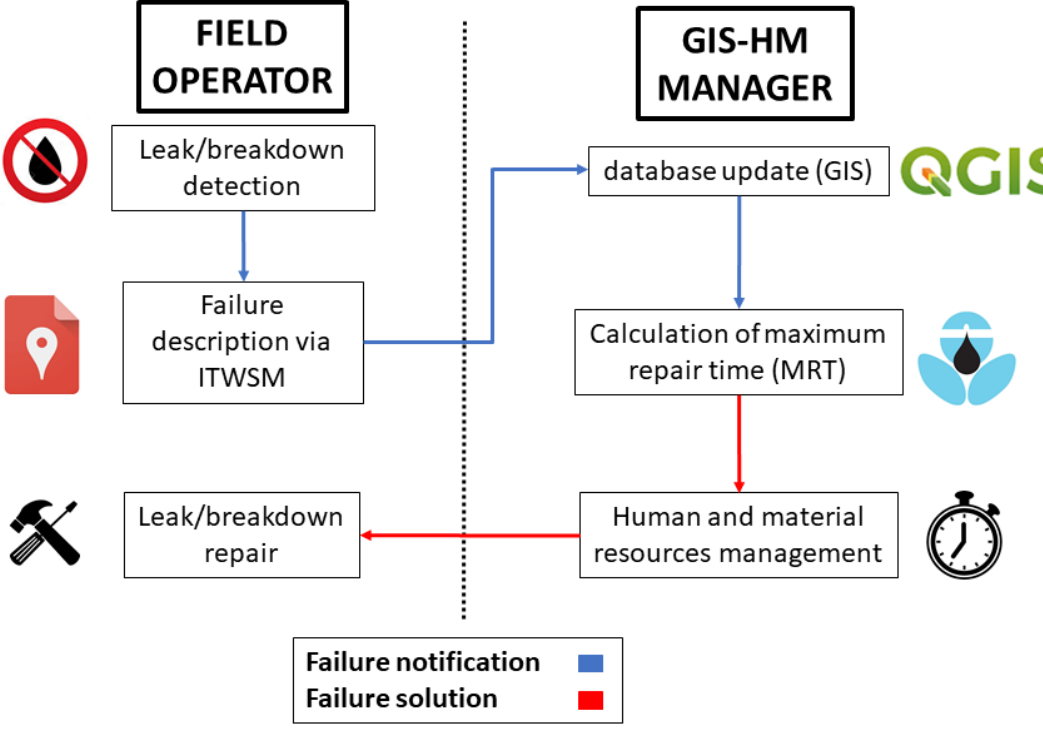
Figure 8. Failure fixing protocol.